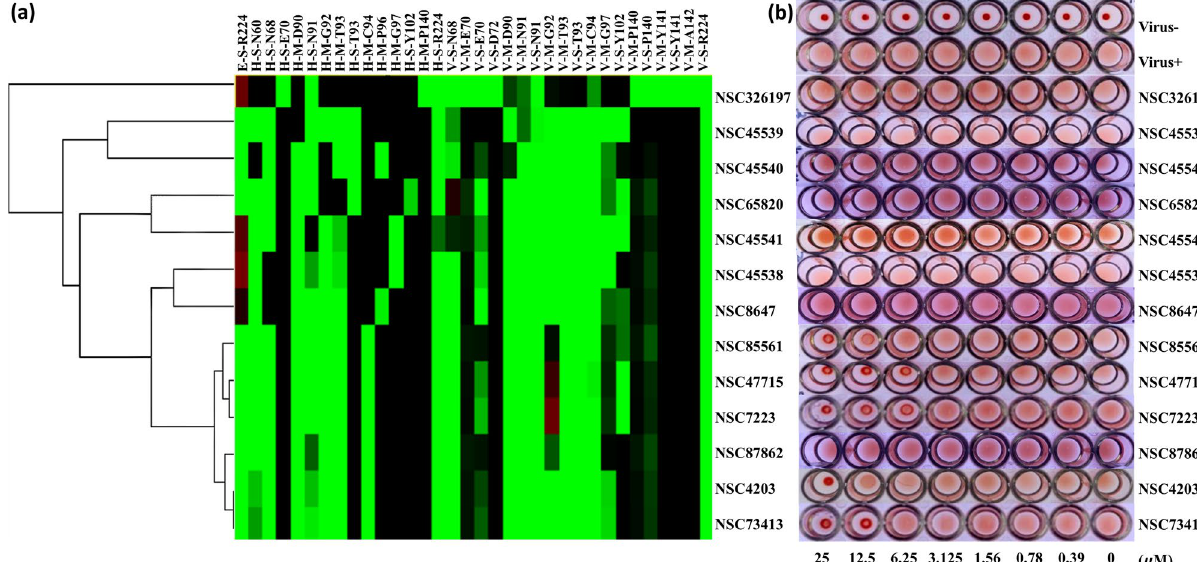
Figure 4. Similar outcomes from the post-screening analysis and HA inhibition assay. (a) The hierarchical clustering and interaction profiles of the 12 derivatives and NSC85561. The hierarchical tree represents compound similarities. The 13 compounds are listed on the y-axis and the interactive residues are listed on the x-axis. The first code of the interactive residue stands for the force between compounds and residues, E for electrostatic force, H for hydrogen bond force, and V for van der Waals forces. The second code stands for the interaction in the main chain (M) or side chain (S). The third code represents the residue type and serial number of the H1N1 HA. Residues with a pharmacological preference value of ≥ 0.4 are colored according to the interaction type: E = red; H = green; V = grey. The H or E interactions are represented in green when the energy ≤ –2.5. The V interactions are in green when the energy is < –4. (b) Representation of agglutination of the 13 compounds in serial two-fold dilutions, starting with 25 µM using the HA inhibition assay and performed in three individual